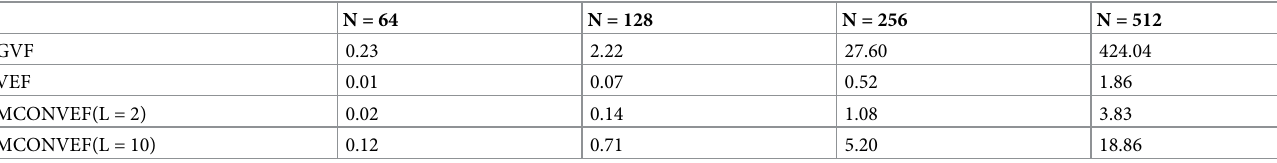
Table 2. Runtime comparison of the MCONVEF, GVF and VEF models in second.